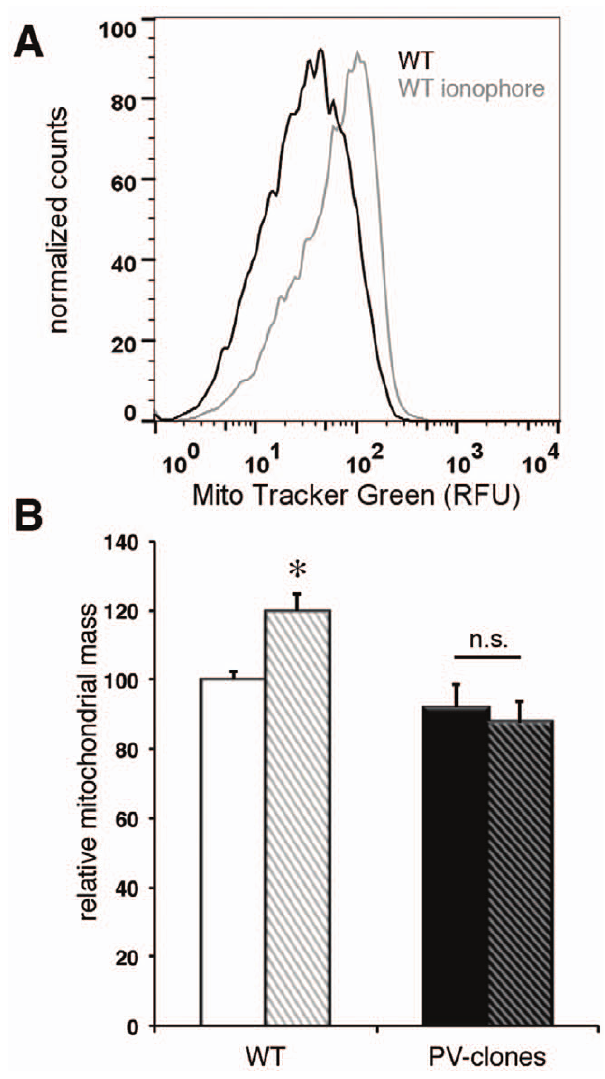
Figure 2. Increased mitochondrial mass determined by FACS analysis in control (WT) C2C12 clones exposed to Br-A23187. A) FACS histogram of WT C2C12 cells treated for 48 h with Br-A23187 (1 m M) and loaded with Mito Tracker Green. A shift to the right (increased relative fluorescence units (RFU)) was observed in WT C2C12 cells. B) Quantitative analysis of relative mitochondrial mass in WT (light bars) and PV-clones (dark bars), before (left bars) and after ionophore treatment (right bars). After ionophore treatment, the mitochondrial mass was significantly increased in the WT clones (*; p , 0.05). In ionophore-treated PV-clones, the relative mitochondrial mass was essentially unchanged, the small decrease was not significant (n.s.). In untreated WT and PV-clones, the small difference was also not significant. Each FACS count was of 20,000 particles (n $ 4 experiments).